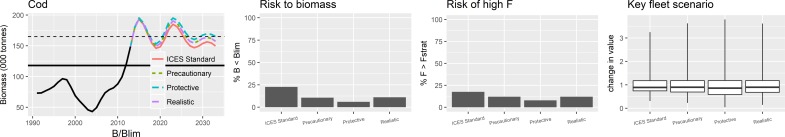
Modelled effect of HCR types on cod metrics for a scenario implementing the NSMAP with fishing at Fmsy by 2020 and incorporating discard avoidance.